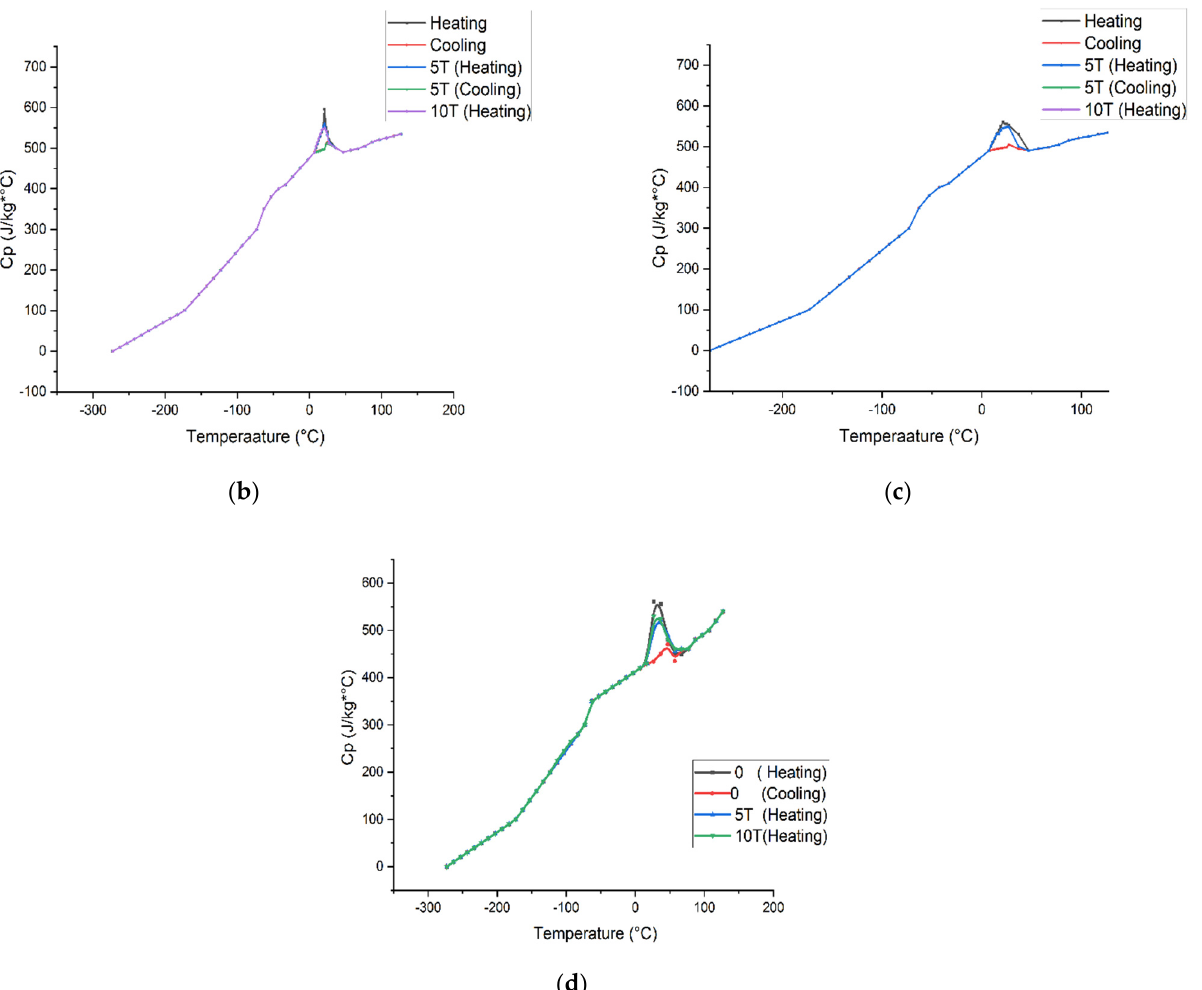
Figure 3. Cp vs. temperature for ( b ) alloy with Fe 3 , ( c ) alloy with Fe 2 , and ( d ) alloy with Fe 1 concen- tration.